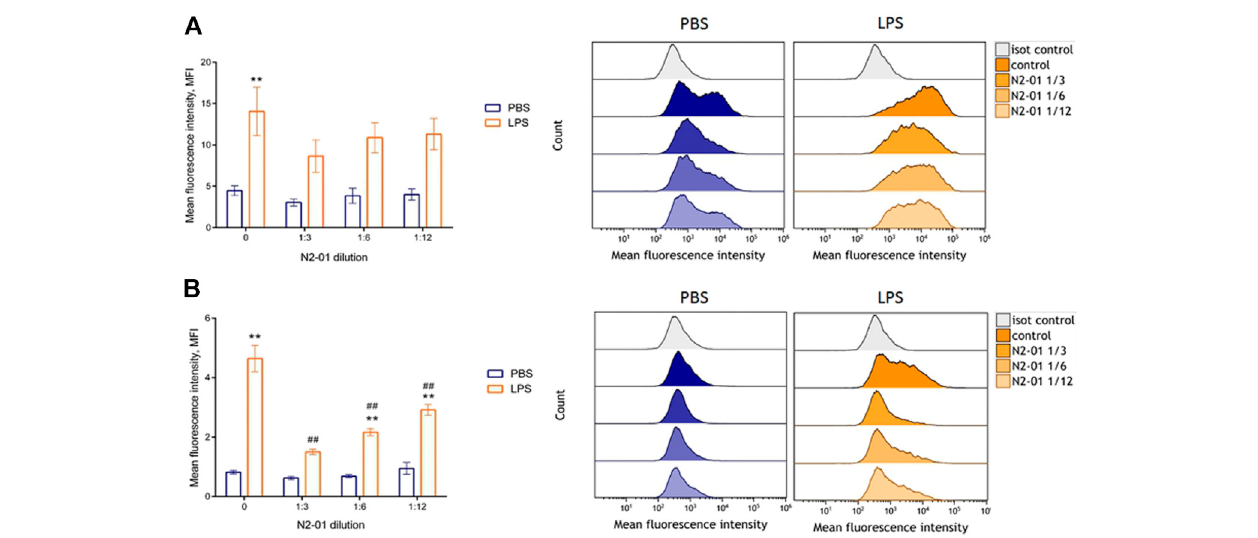
FIGURE6| TheeffectofN2-01ontheICAM-1 (A) andVCAM-1 (B) adhesionmoleculesexpressiononthehumanumbilicalendothelialcells.Statisticalassessment of differences was performed using ANOVA ( p < 0.001), and pairwise comparison of the mean values was performed using the Tukey HSD test. Data are expressed as mean ± SEM of at least four individual experiments ( n (cid:2) 4). The differences are signi fi cant: ** - p < 0.01 vs control; ## - p < 0.01 vs LPS.